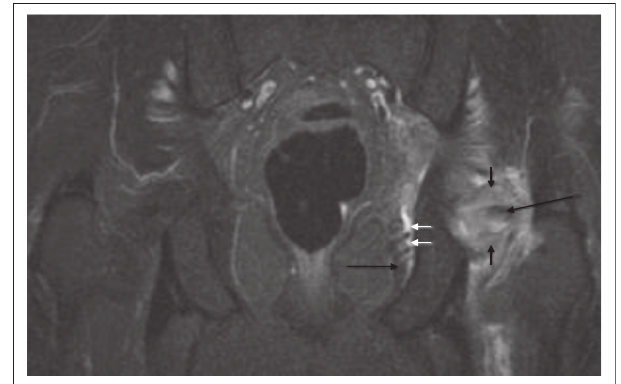
FIGURE 4: Coronal short T1 inversion recovery (STIR) of the pelvis. Oedema of the extrapelvic obturator internus (long black arrow) and gemelli muscles (short black arrows). The medial intrapelvic portion of the obturator internus bursa (short white arrows) and muscle (medium black arrow) are shown.